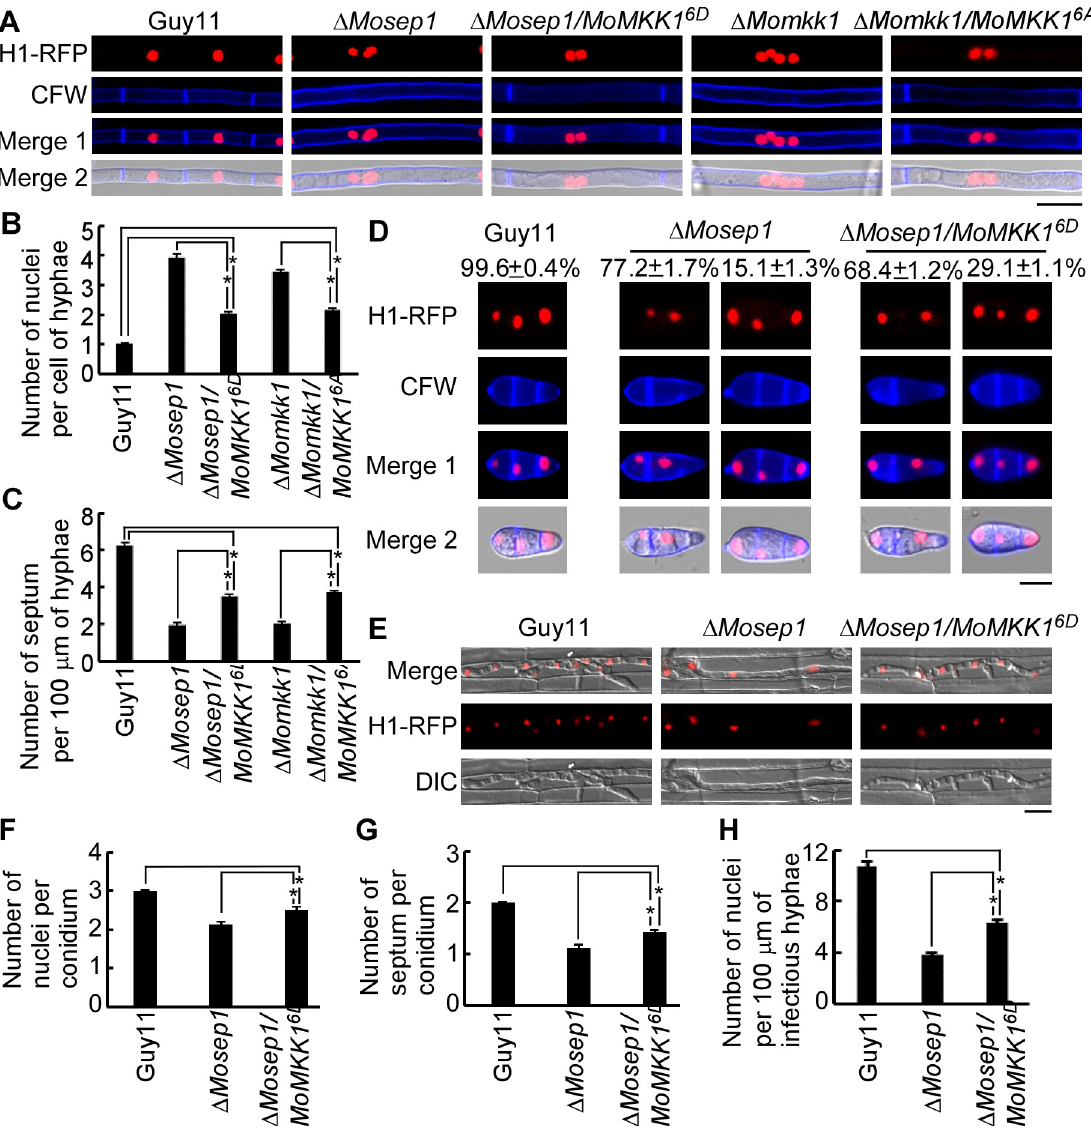
Fig 10. MoSep1-dependent MoMkk1 phosphorylation is vital for MEN in M . oryzae . (A) Hyphae of transformants of Guy11, the Δ Mosep1 , Δ Mosep1/MoMKK1 6D , Δ Momkk1 , Δ Momkk1/MoMKK1 6A mutants expressing the H1-RFP construct were stained with CFW and examined by epifluorescence microscopy. Bar, 10 μ m. (B) Statistical analysis of the number of nuclei per cell of hyphae in (A). One hundred hyphae were counted for each strain and the experiment was repeated three times. Error bars represent the standard deviations. Asterisks indicate statistical significance according to a Student’s test (p < 0.01). (C) Statistical analysis of the number of septa per 100 μ m of hyphae in (A). One hundred hyphae were counted for each strain and the experiment was repeated three times. Error bars represent the standard deviations. Asterisks indicate statistical significance according to a Student’s test (p < 0.01). (D) Conidia of transformants of Guy11, the Δ Mosep1 , Δ Mosep1/MoMKK1 6D mutants expressing the H1-RFP construct were stained with CFW and examined by epifluorescence microscopy. The values mean proportion of corresponding type conidia in the total for each strain. Bar, 10 μ m. (E) Infectious hyphae of Guy11, the Δ Mosep1 , Δ Mosep1/MoMKK1 6D mutants expressing the H1-RFP construct examined by epifluorescence microscopy. Bar, 10 μ m. (F) Statistical analysis of the number of nuclei per conidium in (D). One hundred conidia were counted for each strain and the experiment was repeated three times. Error bars represent the standard deviations. Asterisks indicate statistical significance according to a Student’s test (p < 0.01). (G) Statistical analysis of the number of septum per conidium in (D). One hundred conidia were counted for each strain and the experiment was repeated three times. Error bars represent the standard deviations. Asterisks indicate statistical significance according to a Student’s test (p < 0.01). (H) Statistical analysis of the number of nuclei per 100 μ m infectious hypha in (E). One hundred infectious hyphae were counted for each strain and the experiment was repeated three times. Error bars represented the standard deviations. Asterisks indicate statistical significance (p <